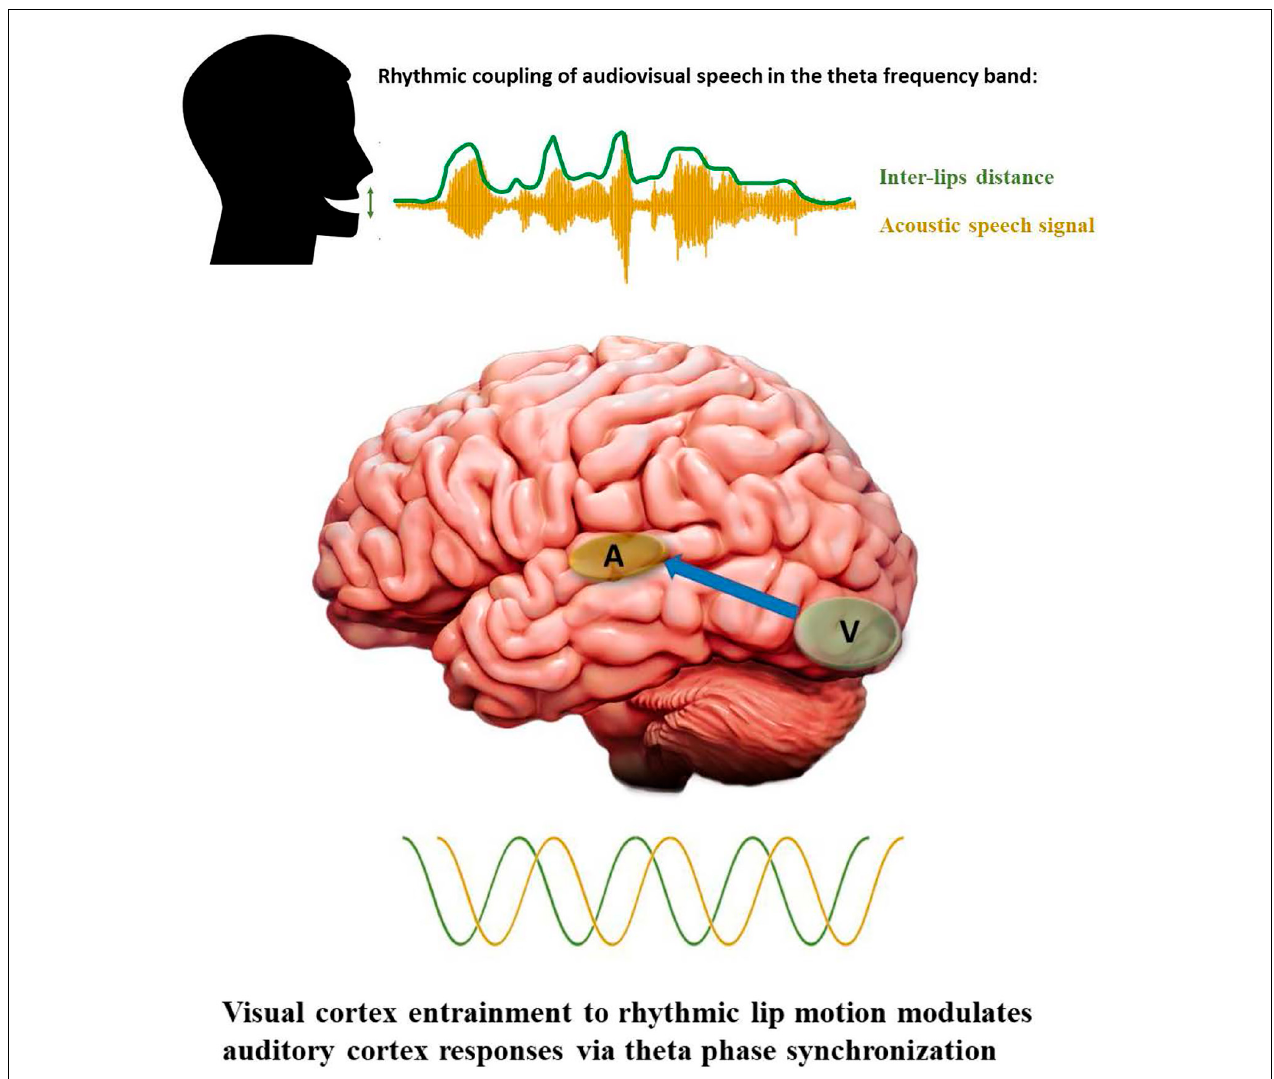
FIGURE 3 | Rhythmic properties of audiovisual speech and cortical oscillations. Visual and auditory speech cues as well as neural oscillations are depicted in green and yellow, respectively. The blue array in the bottom panel indicates feedforward modulation of auditory cortex responses via theta synchronization to visual cortex oscillatory